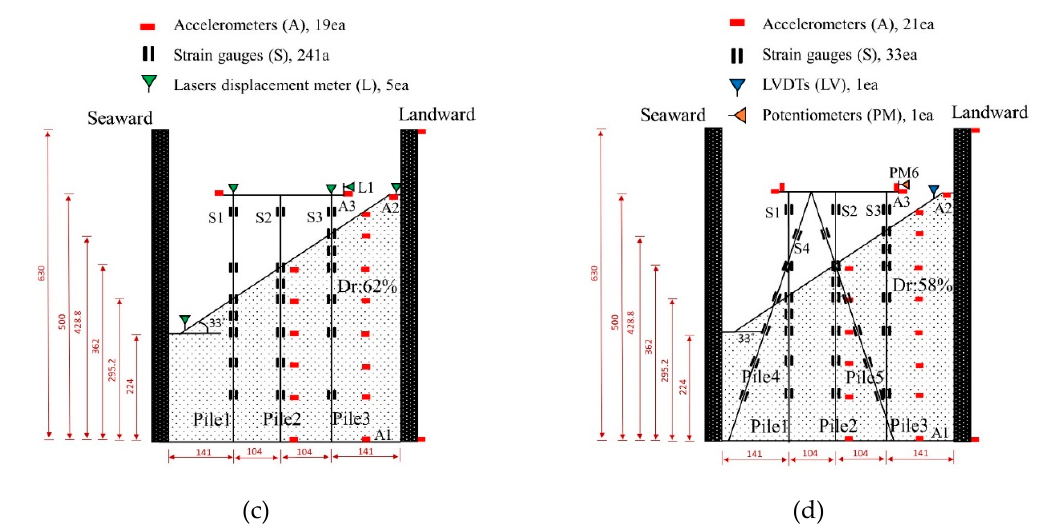
Figure 3. Model cross-section: ( a ) HA45 model; ( b ) HAI55 model; ( c ) IA62 model; and ( d ) IAI58 model.